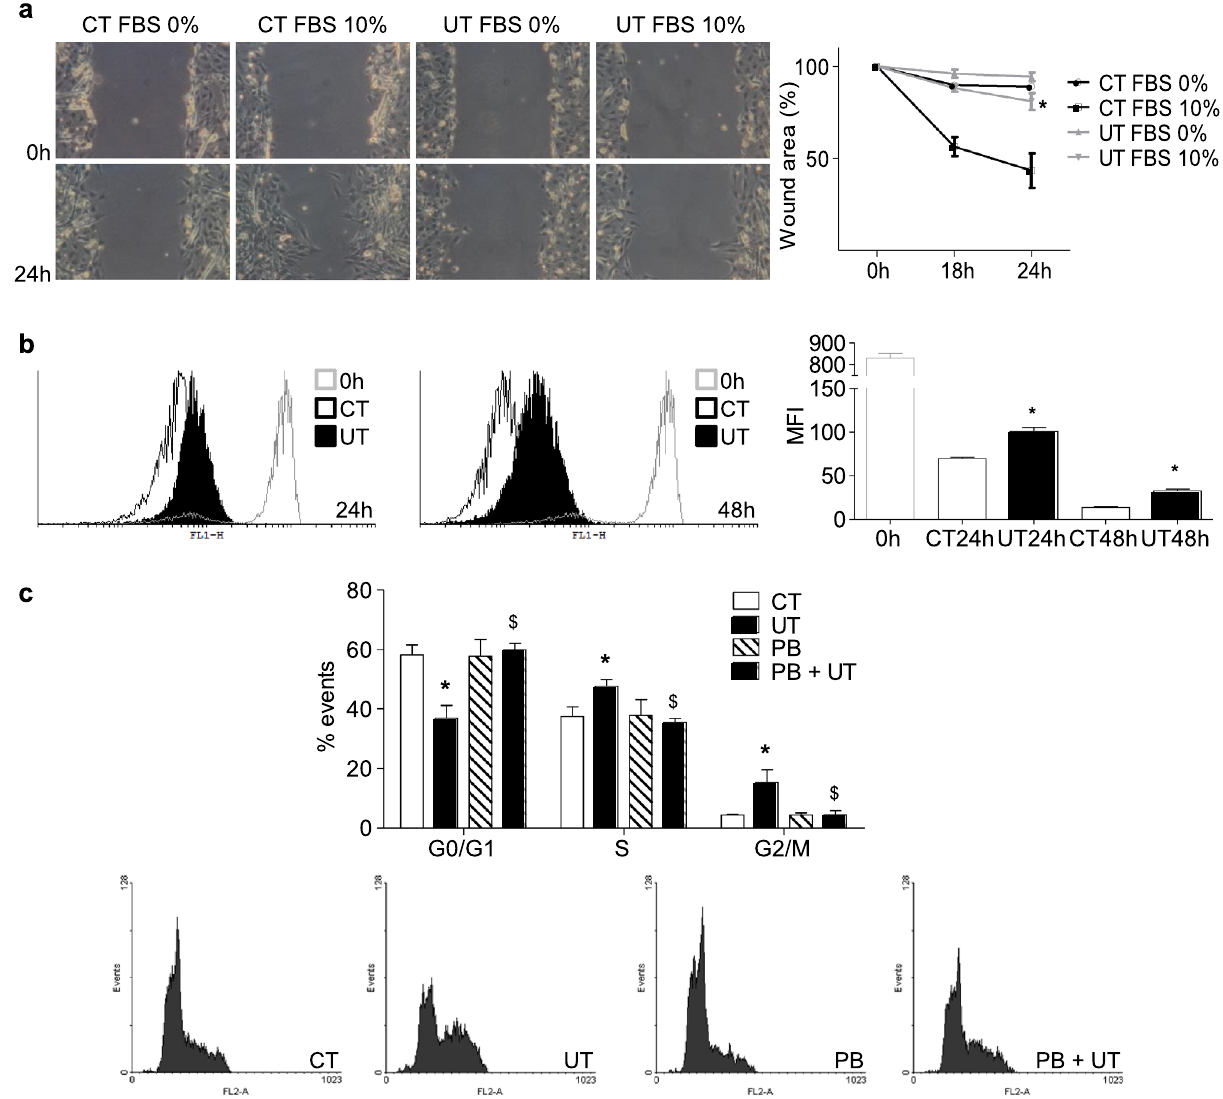
Figure 1. High doses of UT reduced the proliferation capacity of cultured murine myoblasts, arresting the cell cycle between the phases S and G2/M. C 2 C 12 cells were treated with a mixture of 100 µg/mL IS and 100 µg/mL PC (UT) or vehicle (CT) for 48 h. ( a ) Scratch wounding was performed on the C 2 C 12 monolayer and wound closure was monitored over the next 24 h in the presence or absence of 10% FBS. Photographs of wounds were captured at 0, 18, and 24 h post-wounding to determine the degree of wound closure. Representative experiment shows only the 0 and 24 h post-wounding photographs. Graph represents the percentage of control (time 0 h) wound area at different times post-wounding from five experiments. * p < 0.05 between CT FBS 10% and UT FBS 10%. ( b ) Cell proliferation was monitored using CellTrace CFSE solution by flow cytometry during 24 and 48 h. A representative experiment is shown. The bar graph represents the mean fluorescence intensity (MFI). The results are mean ± SEM from five experiments. * p < 0.05 versus CT at the same time. ( c ) C 2 C 12 cells were treated for 48 h in culture medium with 10% FBS in the presence or absence of 0.25 mM probenecid (PB). Propidium iodide incorporation was assessed by flow cytometry. A representative experiment is shown. The bar graph represents the mean ± SEM from four experiments. * p < 0.05 versus CT. $ p < 0.05 versus